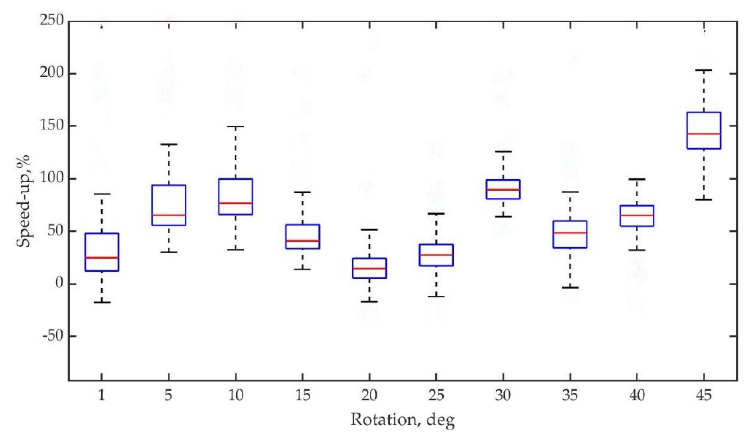
Figure 11. Box-plot of relative intensity-assisted ICP speed-up versus random rotation angle for dataset.